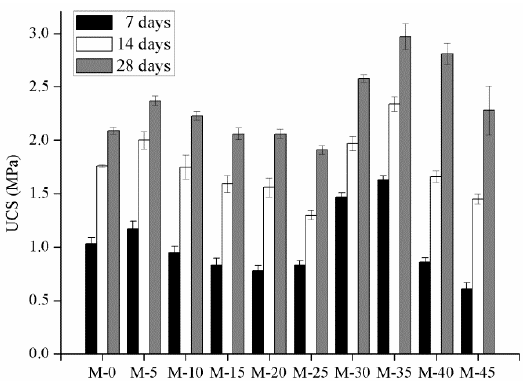
Figure 2. Unconfined compressive strength (UCS) values obtained for the studied mortar specimens (Error bars represent standard deviation).